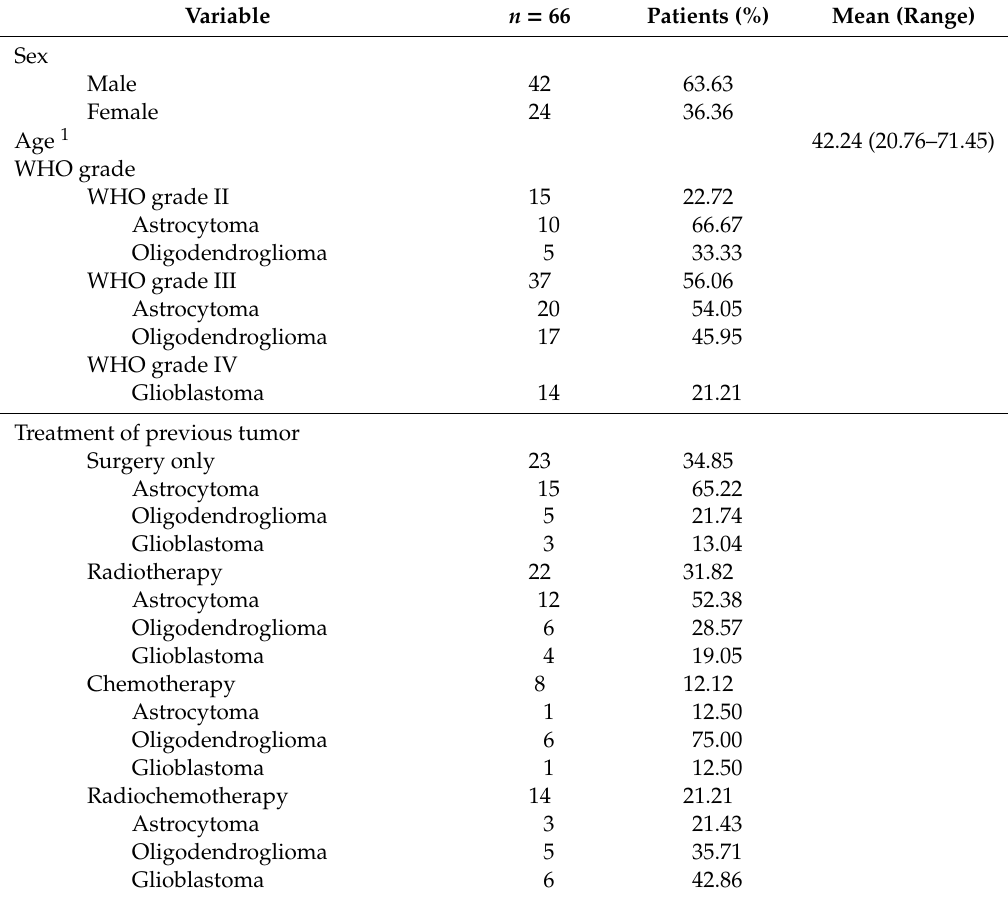
Table 2. Clinical overview of patients with IDH mut recurrent